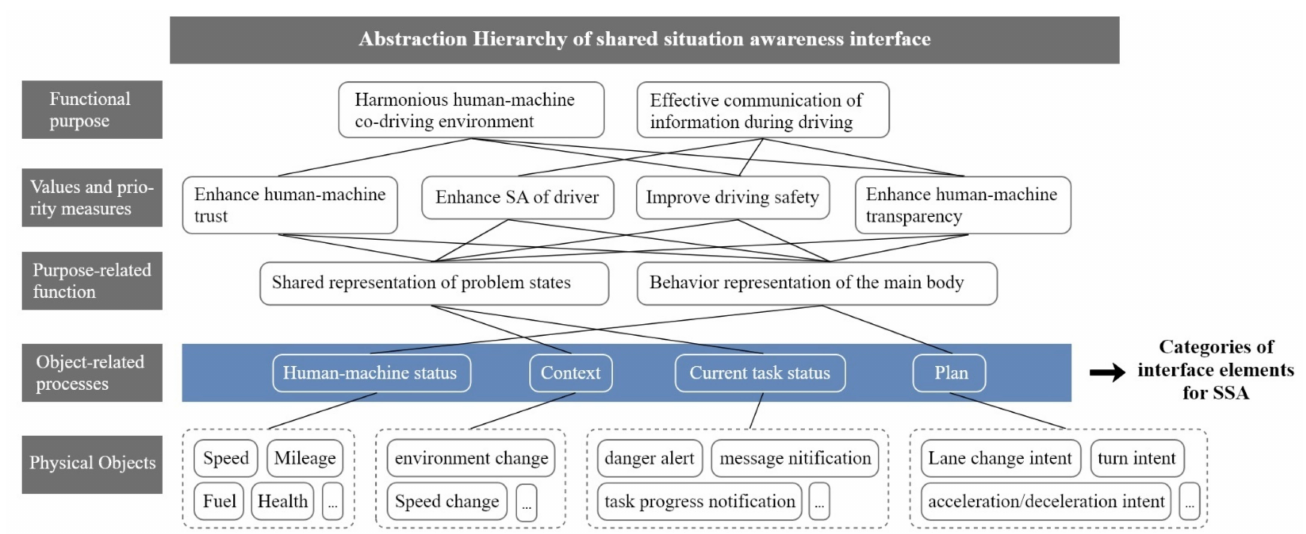
Figure 2. Abstraction Hierarchy of shared situation awareness interface.